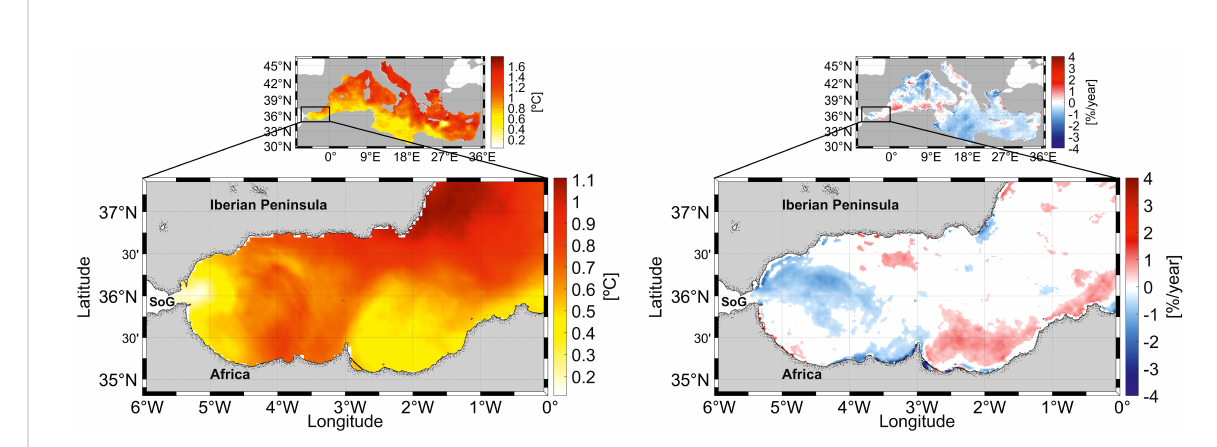
FIGURE 10 Right panels: Sea surface temperature cumulative trend over the period 1993 – 2020 in the Mediterranean (upper side) and in the Alboran Sea (lower side), calculated as the rate of change (°C/year) scaled by the number of time steps (28 years). CMEMS product: SST_MED_SST_L4_; REP_OBSERVATIONS_010_021. Left panels: Mediterranean Sea (top panel) and Alboran Sea (bottom panel) satellite chlorophyll trends over the period 1997 – 2020, expressed in % per year. CMEMS product: